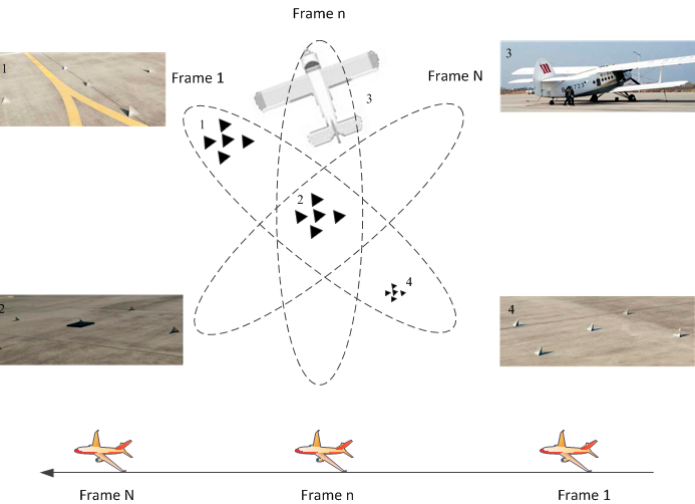
Figure 16. Experimental scene. There are three groups of trihedral corner reflectors and an aircraft in the scene.